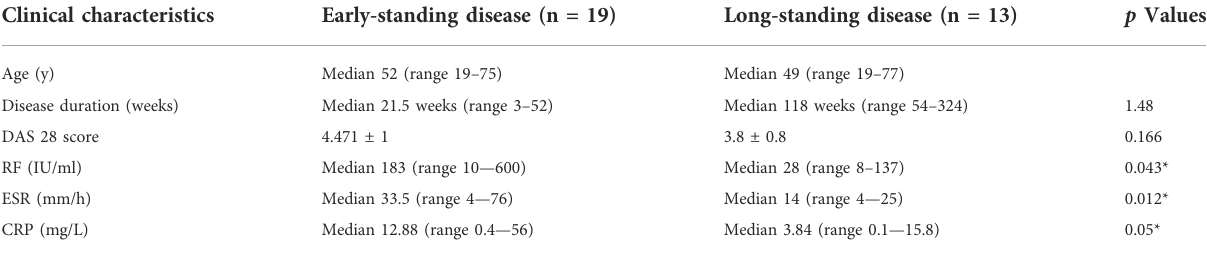
TABLE 1 Clinical characteristics of female RA patients. Clinical